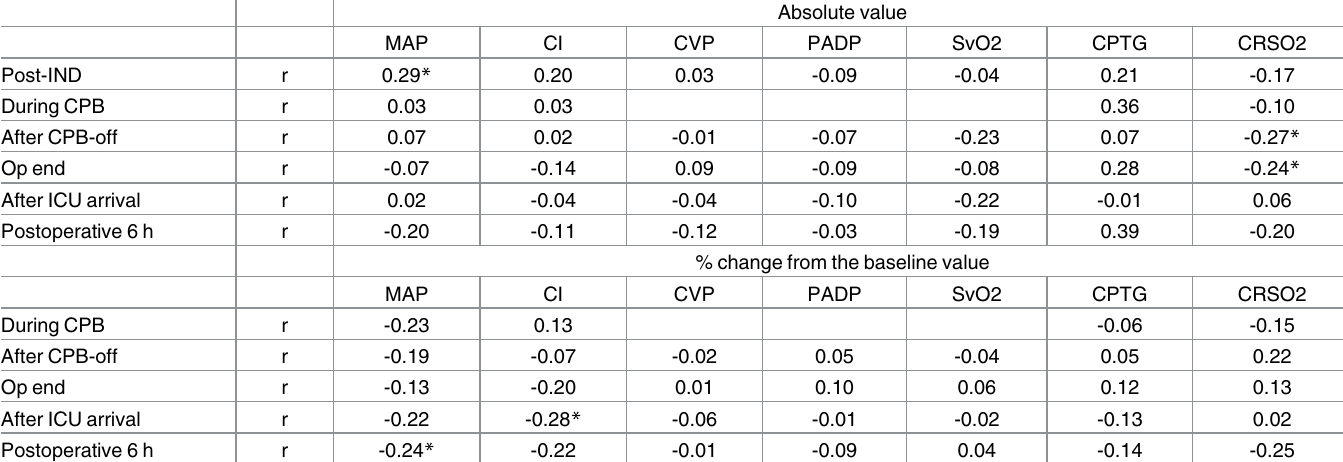
Table 2. Relationship between hemodynamic parameters and postoperative 6 h peak lactate